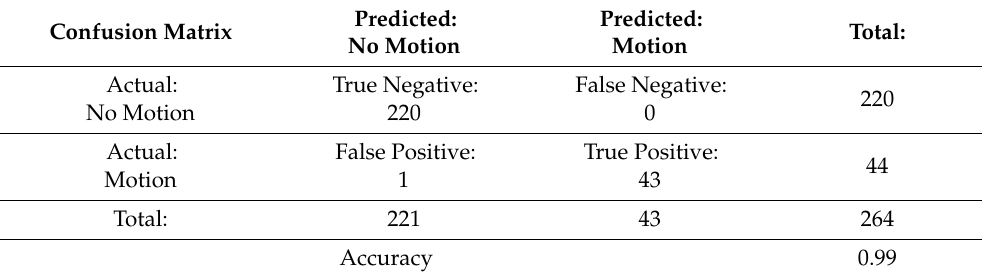
Table 3. Confusion Matrix results on True Positives, True Negatives, False Positives, False Negatives, and